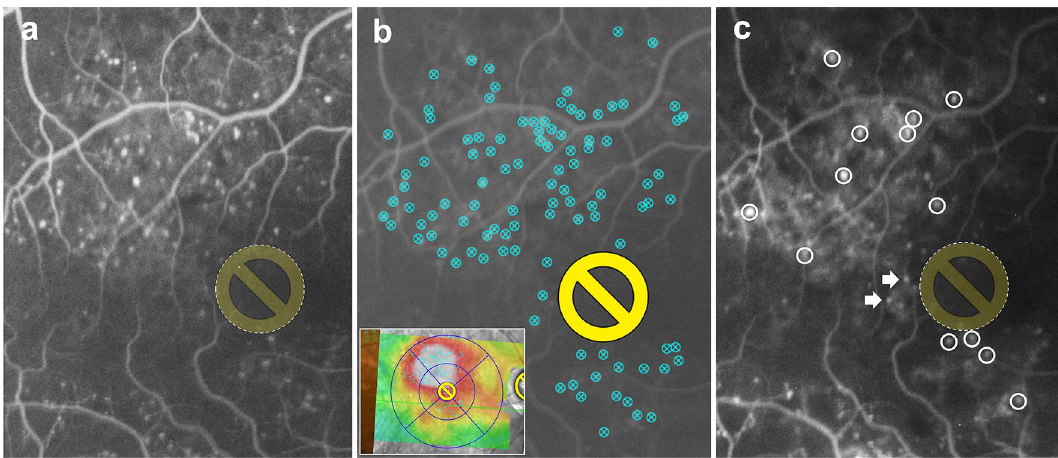
Figure 3. Assessment of microaneurysm closure rate following navigated laser photocoagulation. ( a ) Detection of leaking MA using early-phase FA image before treatment. The yellow circle is an image of the irradiation- prohibited area of the macula. ( b ) Marked laser spots for leaking MA within the edematous area on the OCT map in the laser planning procedure. Additional image below shows the OCT map and laser irradiated spots. ( c ) Postoperative FA image. Closed MAs were defined as an absence of or inactive focal hyperfluorescence. White circles indicate hyperreflective spots, which were considered as residual MAs, and white arrows indicate new MAs appearing during the laser procedure, which were not considered as residual MAs. MA, microaneurysm; FA, fluorescein angiography; OCT, optical coherence